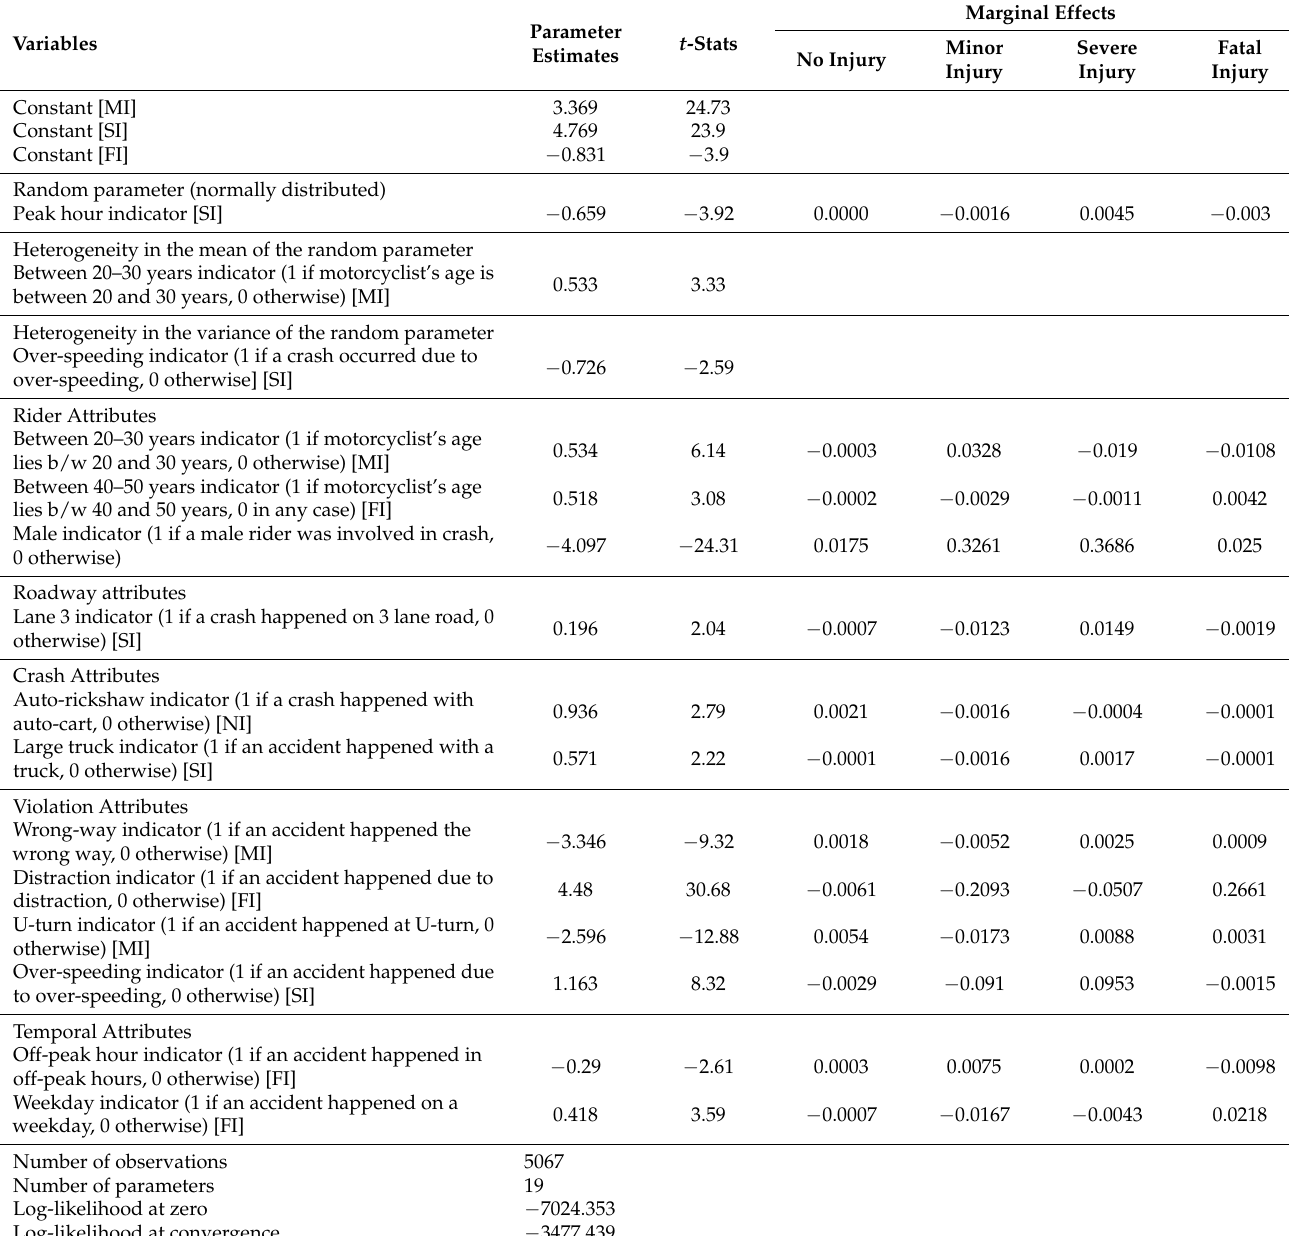
Table 9. Model estimation results for non-helmet-wearing motorcycle crashes